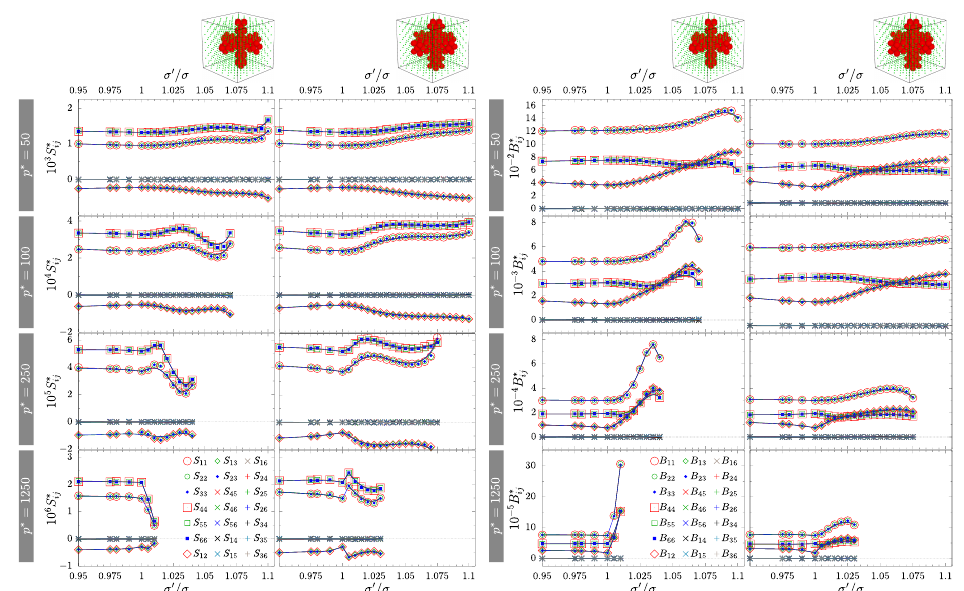
Figure 5. Components of the elastic compliance matrix S ( left ) and matrix of elastic constants B ( right ) for systems with crossing D -type and S -type nanochannels. Corresponding values of reduced external pressure p ∗ are indicated in the figure. The simulation errors of the values are below 3% and they are considerably smaller than the symbols representing them. The quantities represented by cross and plus symbols (x and +) are equal to zero within the computational error.